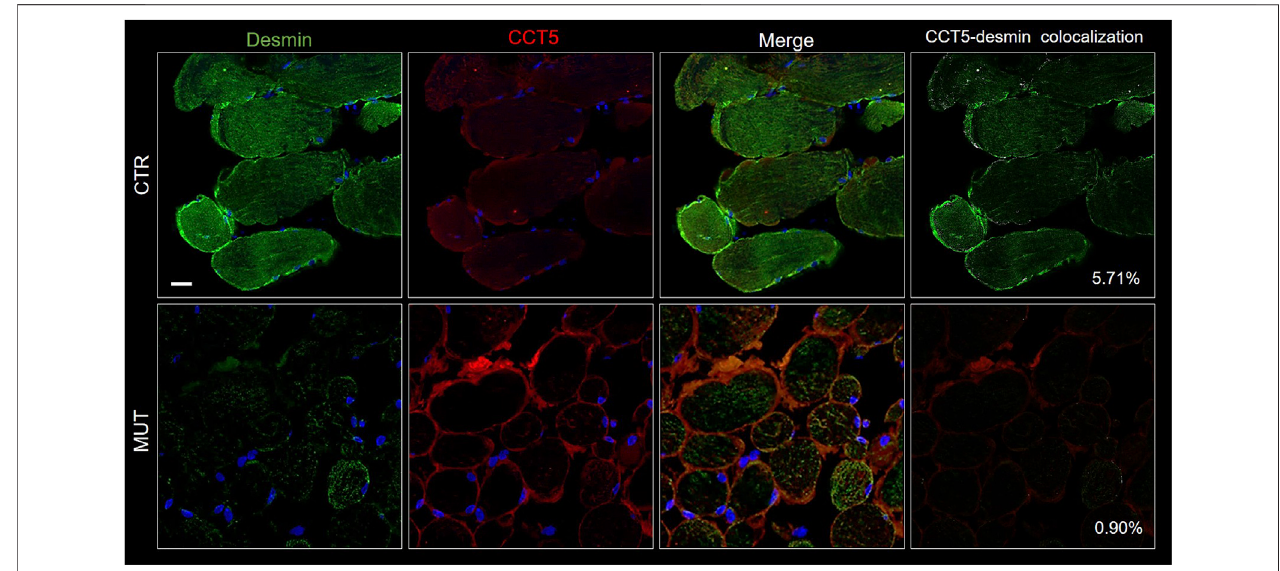
FIGURE7| Double immuno fl uorescencewith FITC-conjugatedantibody fordesmin (green) and withTRITC conjugatedanti-CCT5 antibody (red) inCTRand MUT muscles. Solid desmin positivity at the costamer level occurred in CTR muscle while it appeared as disorganized dots in the MUT muscle. CCT5 and desmin colocalization was reduced in MUT muscle (0.90%) as compared with the CTR muscle (5.71%). Nuclei were stained with probe Hoechst 33342 (blue). Bar = 25 µm.